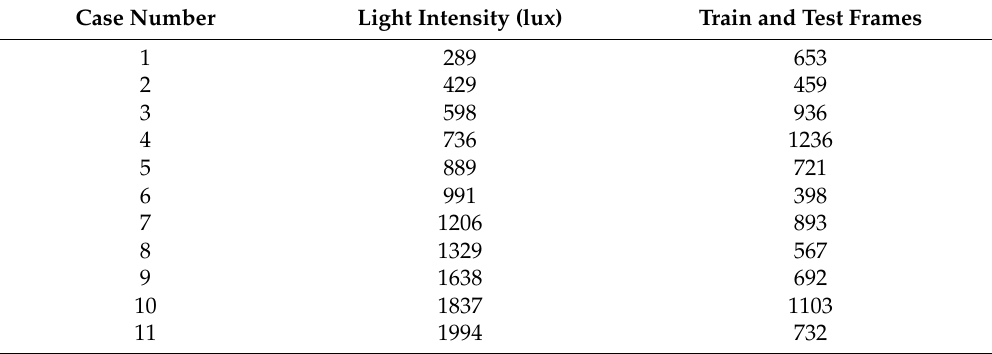
Table 1. Description of the images of the dataset. Each case corresponds to a video, from which different frames were extracted. The videos are ordered from lower to higher luminous intensity.